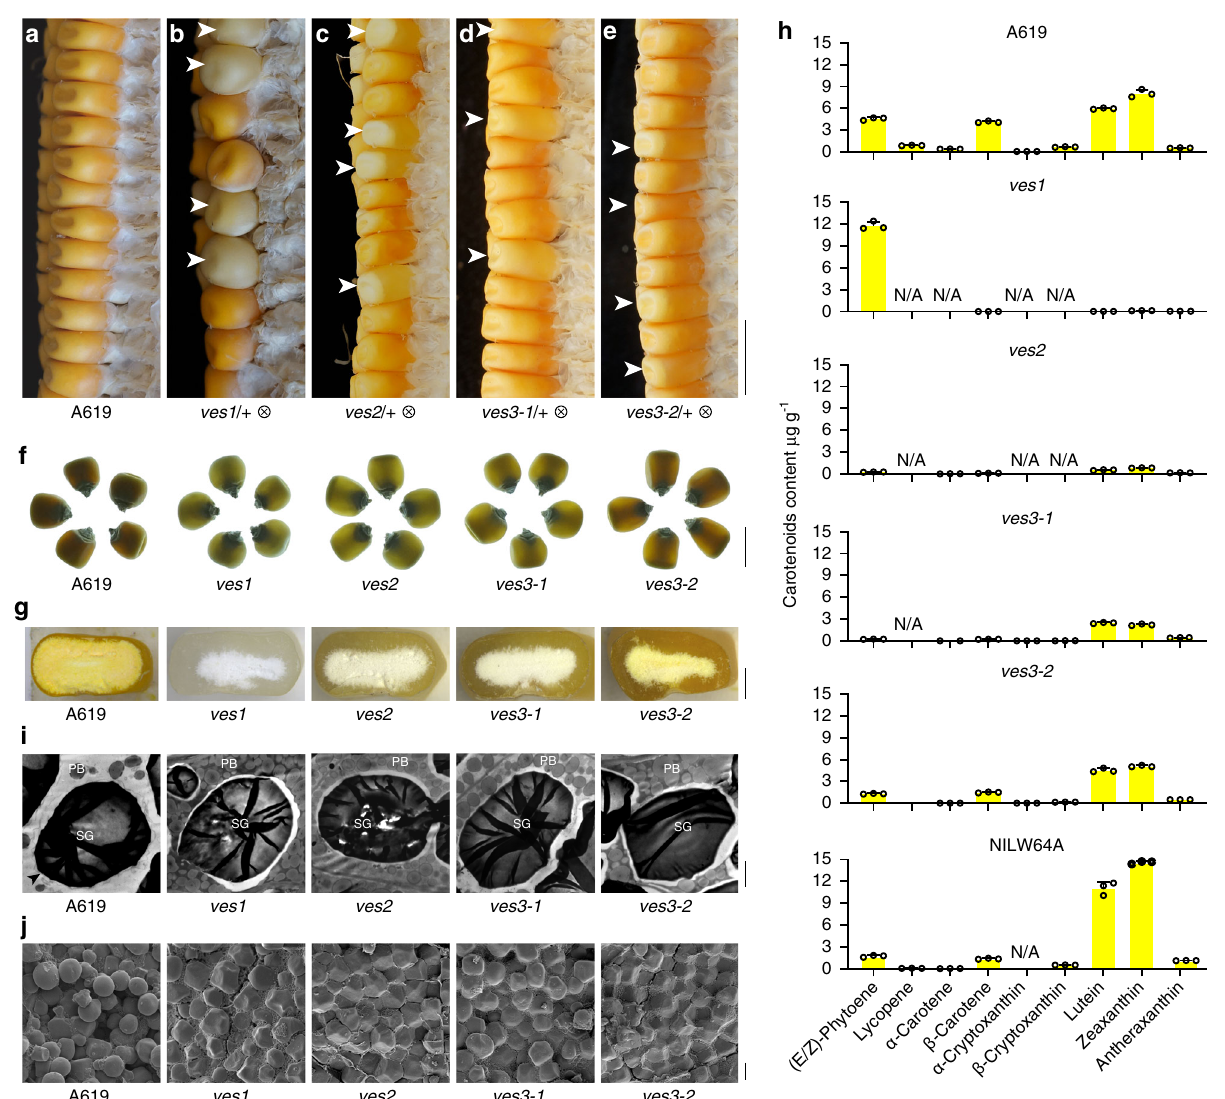
Fig. 4 Screening suppressors of Ven1 A619 . a A619 ear; b – e Ears segregating ves1 ( b ), ves2 ( c ), ves3-1 ( d ) and ves3-2 ( e ). Vitreous and carotenoid synthesis defective kernels are indicated with white arrowheads. Scale bar, 1 cm. f Kernel vitreousness of A619 and the suppressors as observed on the light box. Scale bar, 1 cm. g Kernel transverse sections of A619 and the suppressors. Scale bar, 5 mm. h Altered carotenoid composition in endosperm tissues of A619, suppressors and NILW64A. Data are presented as mean values ± SD, n = 3 biological replicates. i TEM of the A619 and suppressors endosperm cells at 30 DAP. SG, starch grain; PB, protein body. Arrowheads indicate the amyloplast membranes. Scale bar, 2 μ m. j SEM of the A619 and the suppressors endosperm cells at 30 DAP. Scale bar, 10 μ m. The source data underlying h are provided as a Source Data fi